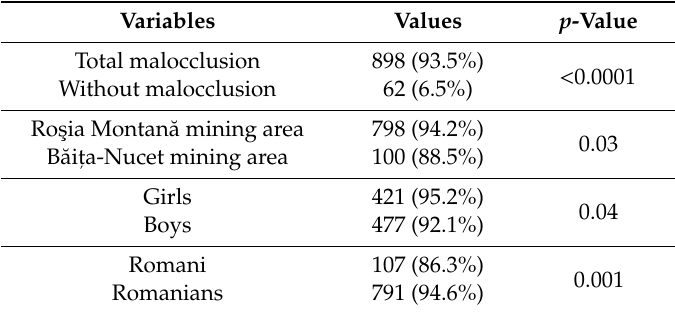
Table 2. Distribution of total malocclusions by environment, gender and ethnicity.